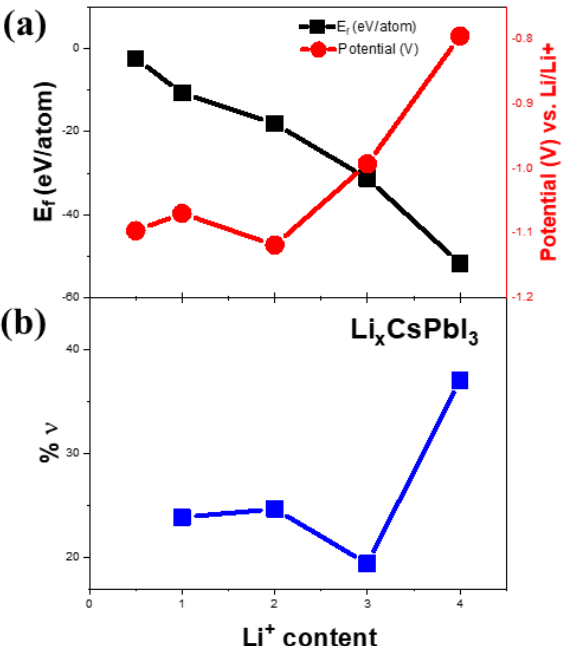
Figure 6. ( a ) Calculation of formation energies as a function of lithium content. The right vertical axis represents the lithiation potential as a function of lithium content in ( a ). Theoretically calculated volume change (%ν) as a function of lithium content is shown in ( b ).